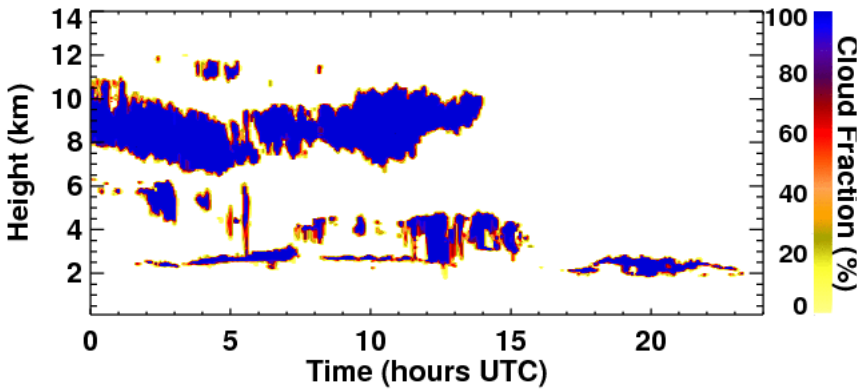
Fig. 4. An example of a time series of the ARSCL profile on 21 May 2003 at SGP. Note that the “cloud fraction” is actually referred to the frequency of occurrence, but is used here to avoid potential confusion with “times of occurrence” of Figs. 1–3.